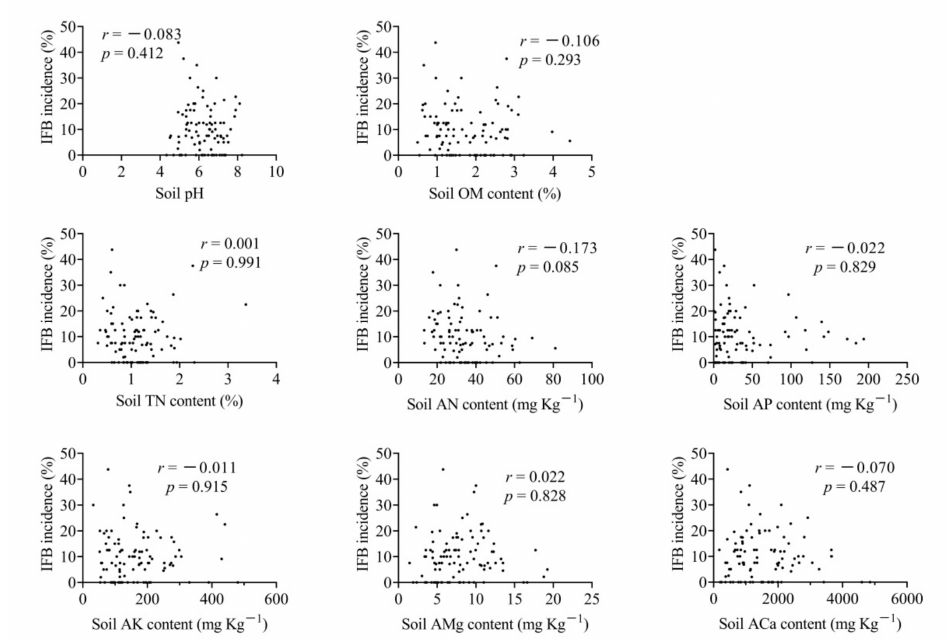
Figure 12. Relationship between internal flesh breakdown incidence and soil pH and mineral